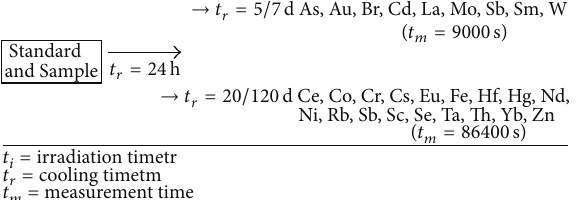
(USGS) nn. 1, 4, 6 and the Coal Fly Ash (NIST) n. 1633a were used.